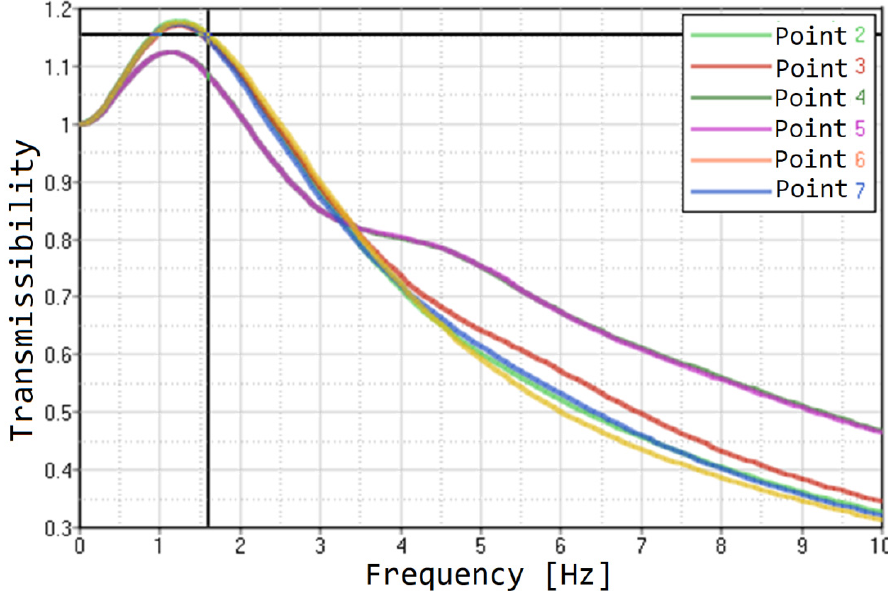
Figure 9. Transmisibility in the center of mass of the platform excited with a harmonic vibration in the OX direction.